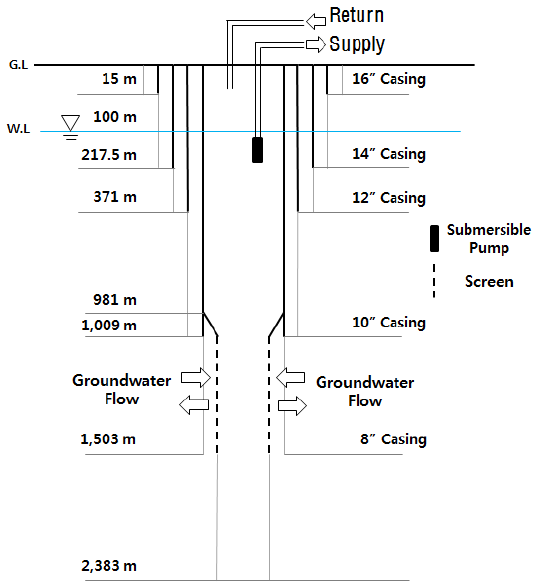
Figure 3. Conceptual sketch of a deep geothermal well. Reproduced with permission from [14,18].